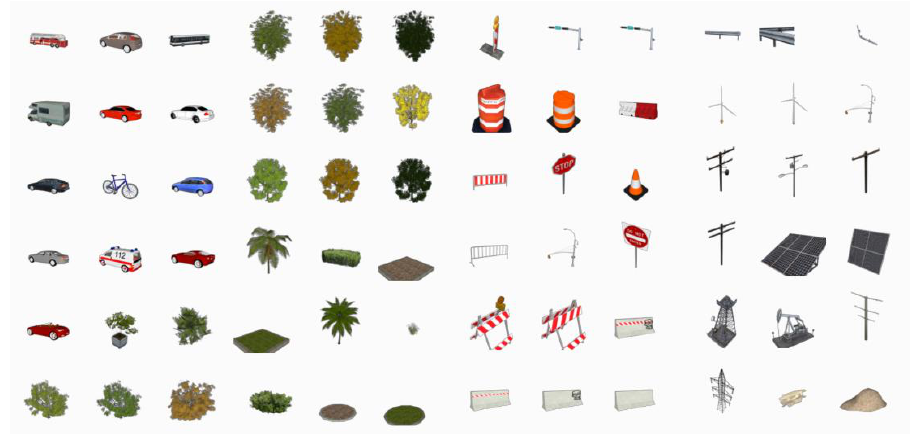
Figure 2. Some object components available in AIF.